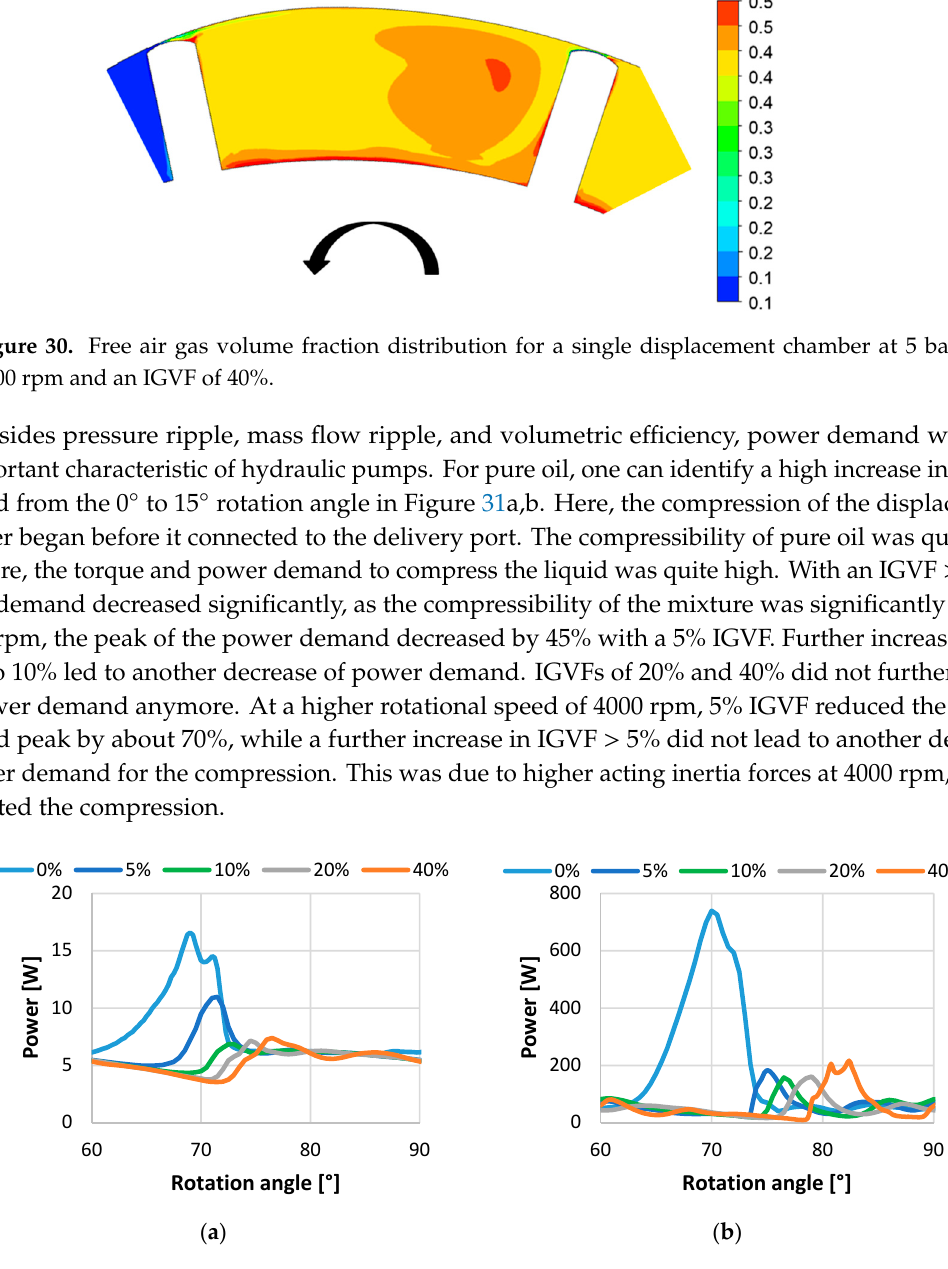
( b ) Figure 29. Influence of the IGVF of free air on the instantaneous outlet 1 mass flow rate at 5 bars,